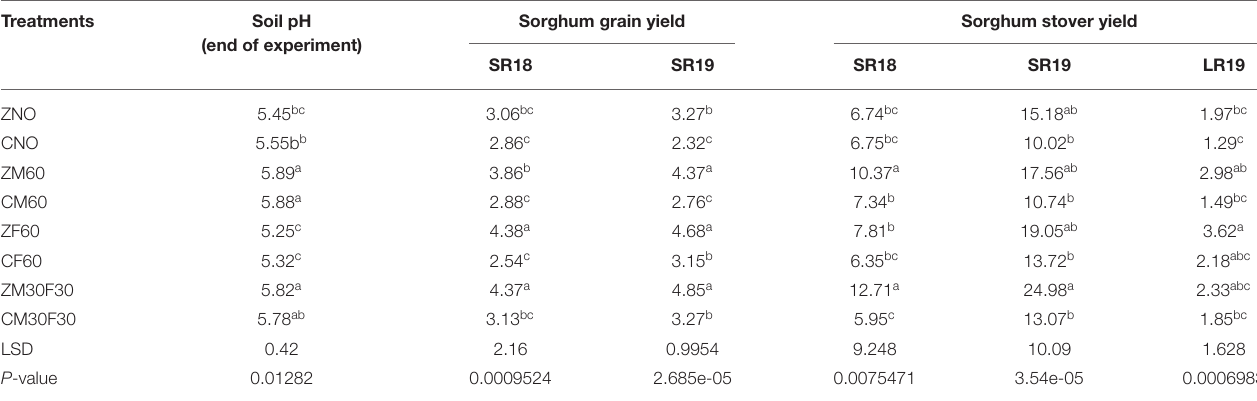
TABLE 4 | Interaction effects of Zai technology and selected nutrient amendment options on Soil pH and sorghum grain and stover yields in the short rains’ seasons of 2018 and 2019 (SR18 and SR19) and the long rain season of 2019 (LR19).